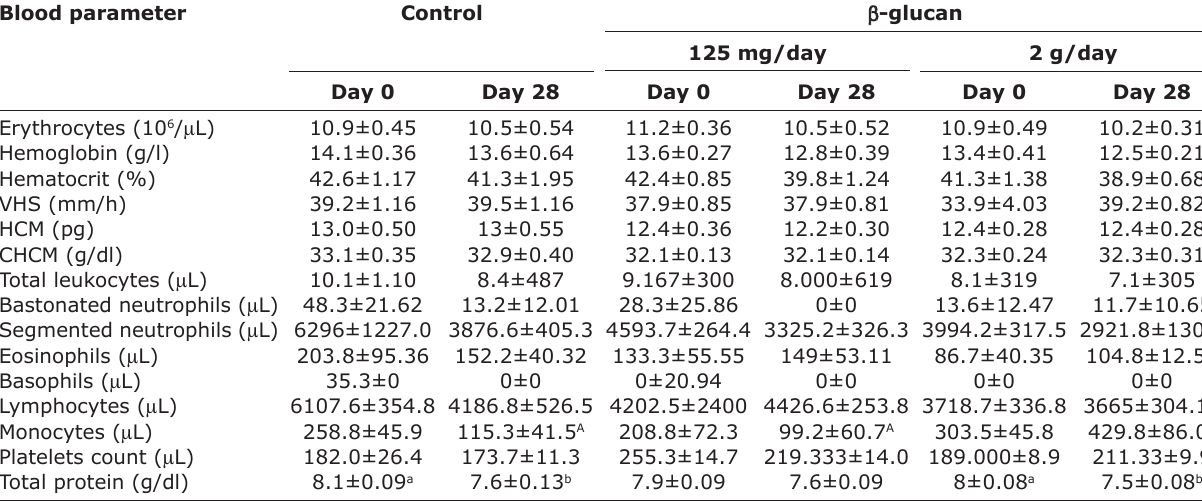
Table 1: Hematological parameters of horses fed β -glucan. Blood samples were collected before (day 0) or after the feeding regimen (day 28). The data represent the mean±SEM (n=6). Blood parameter